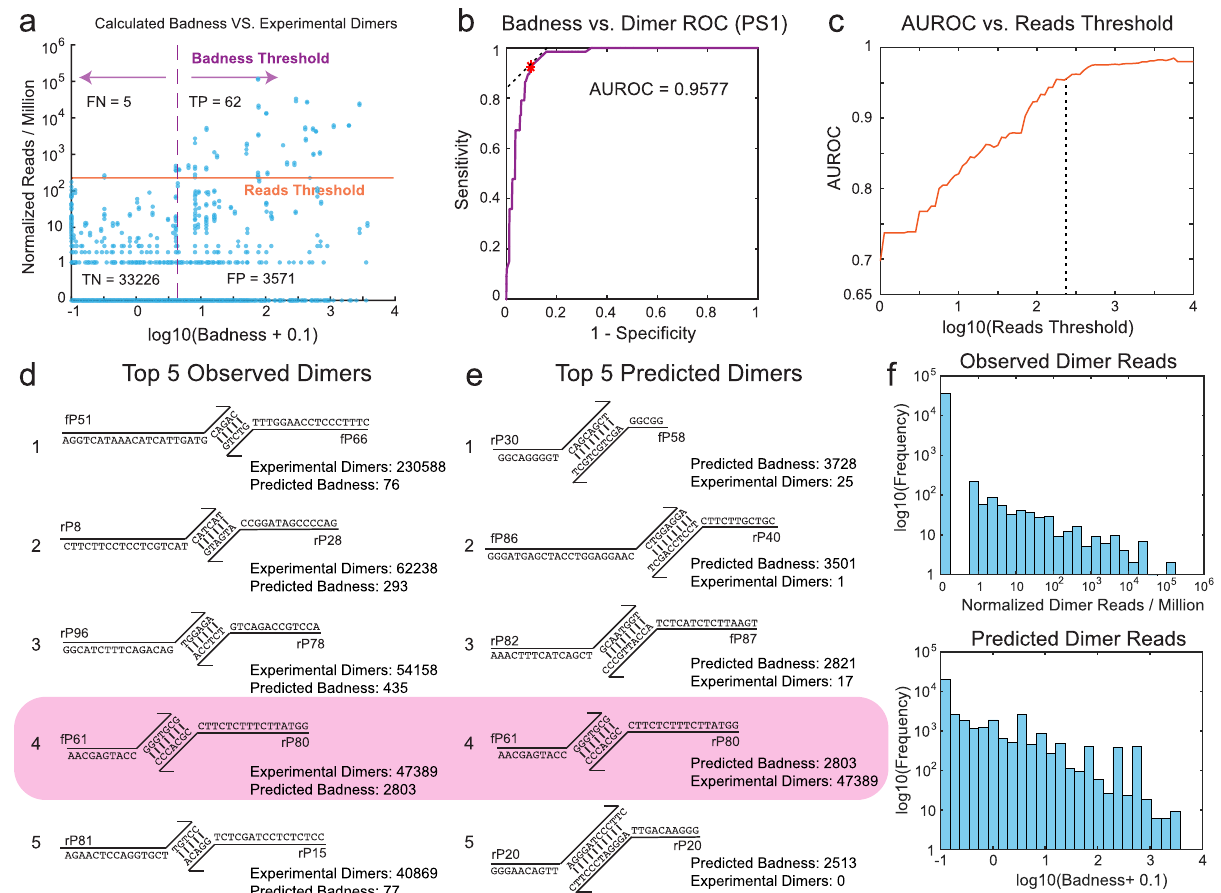
Fig. 4 Evaluation of prediction accuracy of the Badness function for individual primer dimer candidates. a Comparison of observed vs. predicted primer dimers for all possible pairs of primers in the PS1 library. The horizontal orange line shows the mean on-target reads for the 96 intended amplicons. By changing the Badness Threshold, different tradeoffs of dimer prediction sensitivity and speci fi city can be achieved. For the current Reads Threshold and Badness Threshold, we observe 92.5% sensitivity and 90.3% speci fi city. b Receiver operator characteristic (ROC) curve for dimer prediction sensitivity and speci fi city achieved by changing the Badness Threshold. c The Area Under the ROC (AUROC) value depends on the Reads Threshold, with a highest achievable AUROC of about 0.98. d The top fi ve dimer species experimentally observed to form with highest number of aligned NGS reads. e The top fi ve potential dimer species predicted to form based on the Badness function. Note that only the #4 species are present are both list in panels d and e . f Distribution of observed NGS reads and predicted Badness for all possible primer